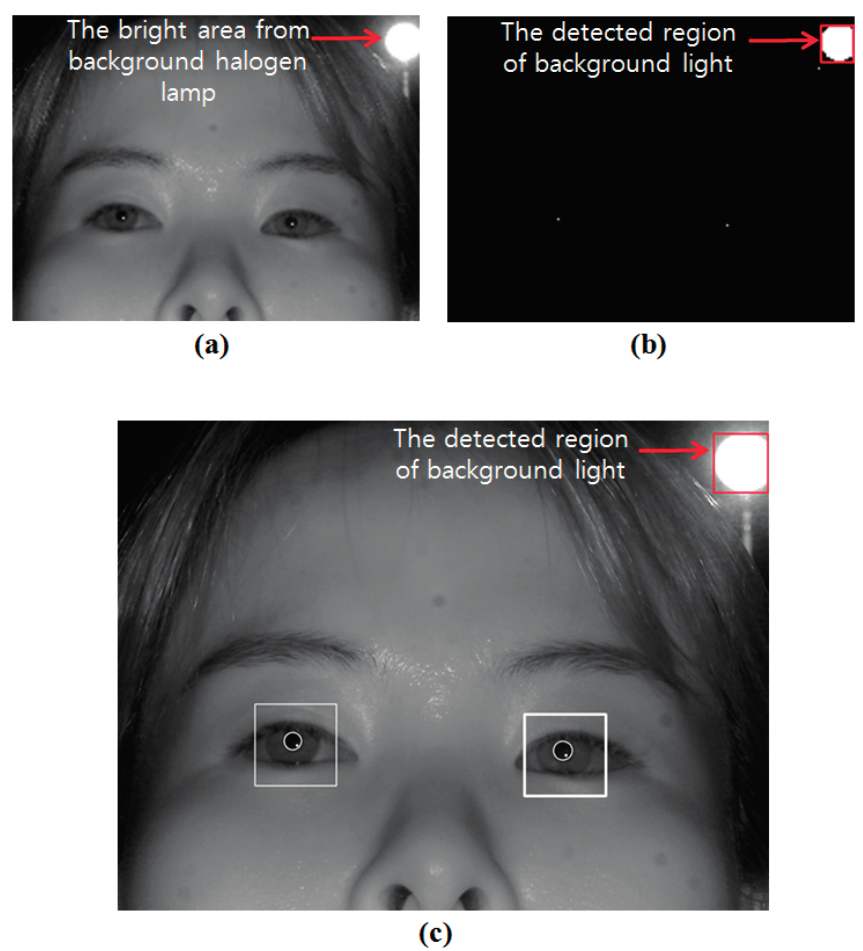
Figure 6. Step to remove external light behind user ( a ) the sub-sampled image of 1/8 size ( b ) binarized image ( c ) result